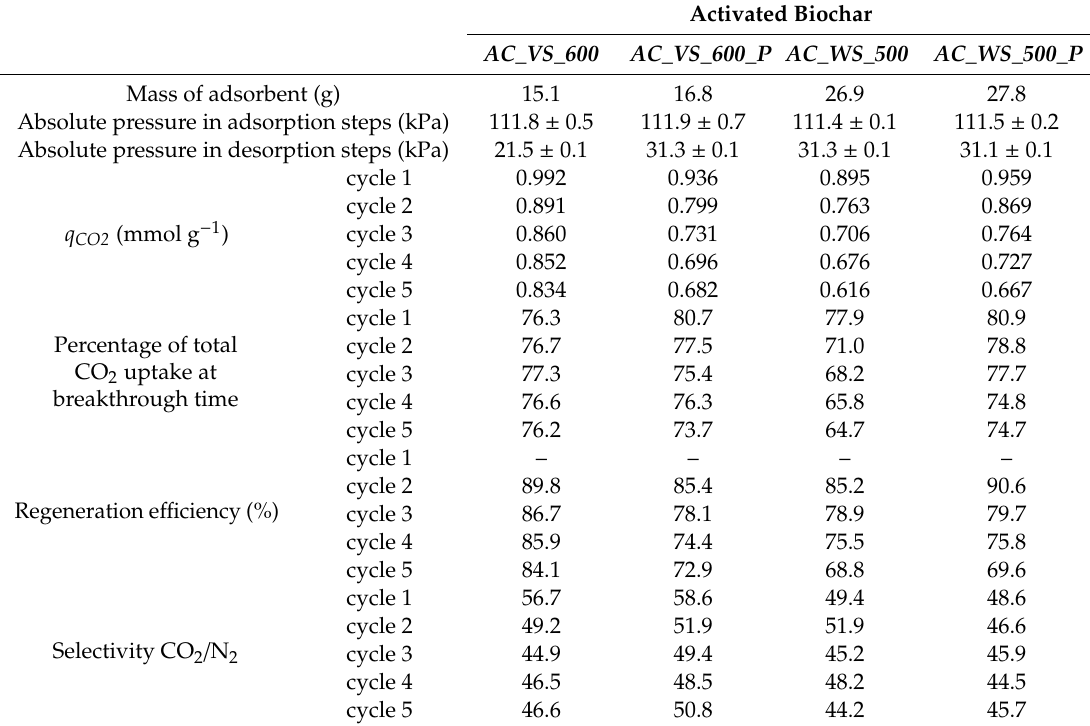
Table 5. Summary of results from the breakthrough experiments (dry conditions) conducted at 25 ◦ C.